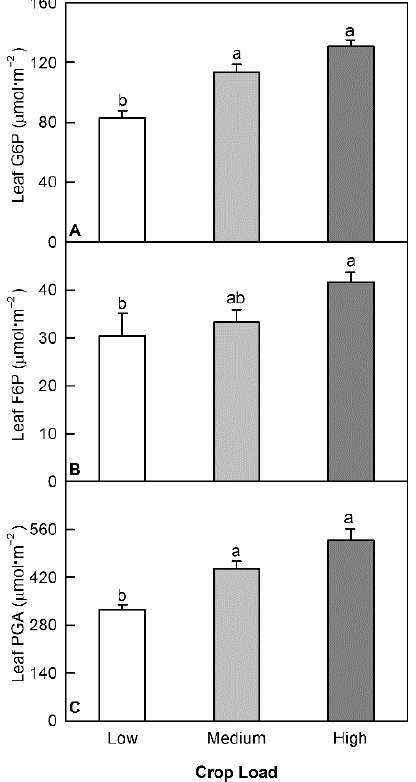
Figure 4. Effects of crop load on the concentrations of carbon metabolism intermediates in apple leaves at noon: glucose-6-phosphate (G6P, A ), fructose-6-phosphate (F6P, B ), and 3-phosphoglycerate (PGA, C ). Each bar is mean ± SE ( n = 5). Different letters above the bars indicate a significant difference for Tukey’s HSD test at p < 0.05.